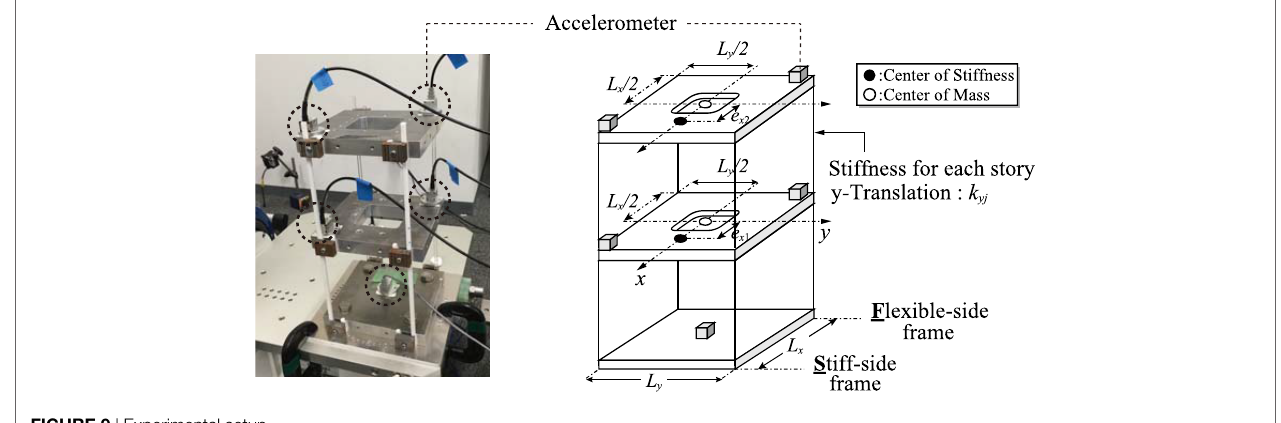
FIGURE 9 | Experimental setup.